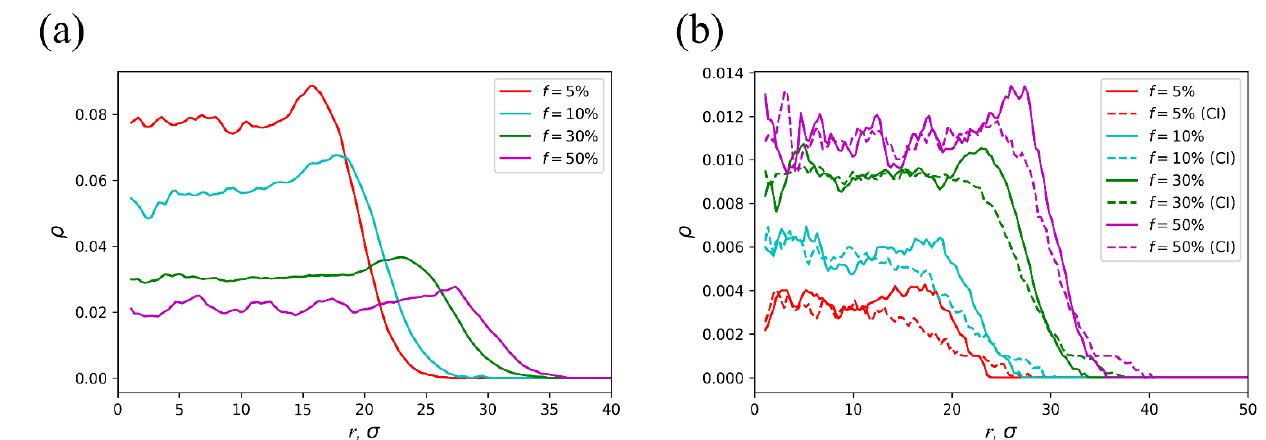
Figure 7. ( a ) Polymer volume fraction, ( b ) volume fraction of the network charged groups (solid) and counterions (dashed) as functions of the radial coordinate r at different f values and favorable solvent conditions, ε = 0.01 kT . The molecular weight and subchain length of the microgel are N = 100,000 and M = 10, respectively. The initial aspect ratio is A = 10.